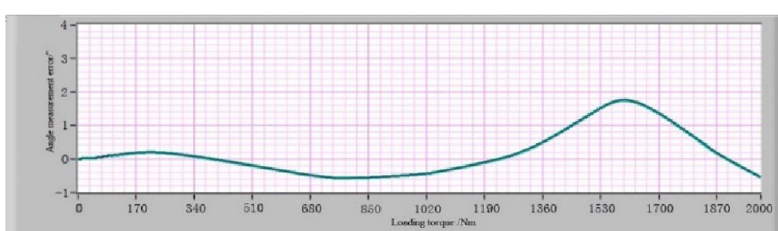
Figure 14. Errors of MSOS after compensation using the IBSCF-GDPSO-RBF method.